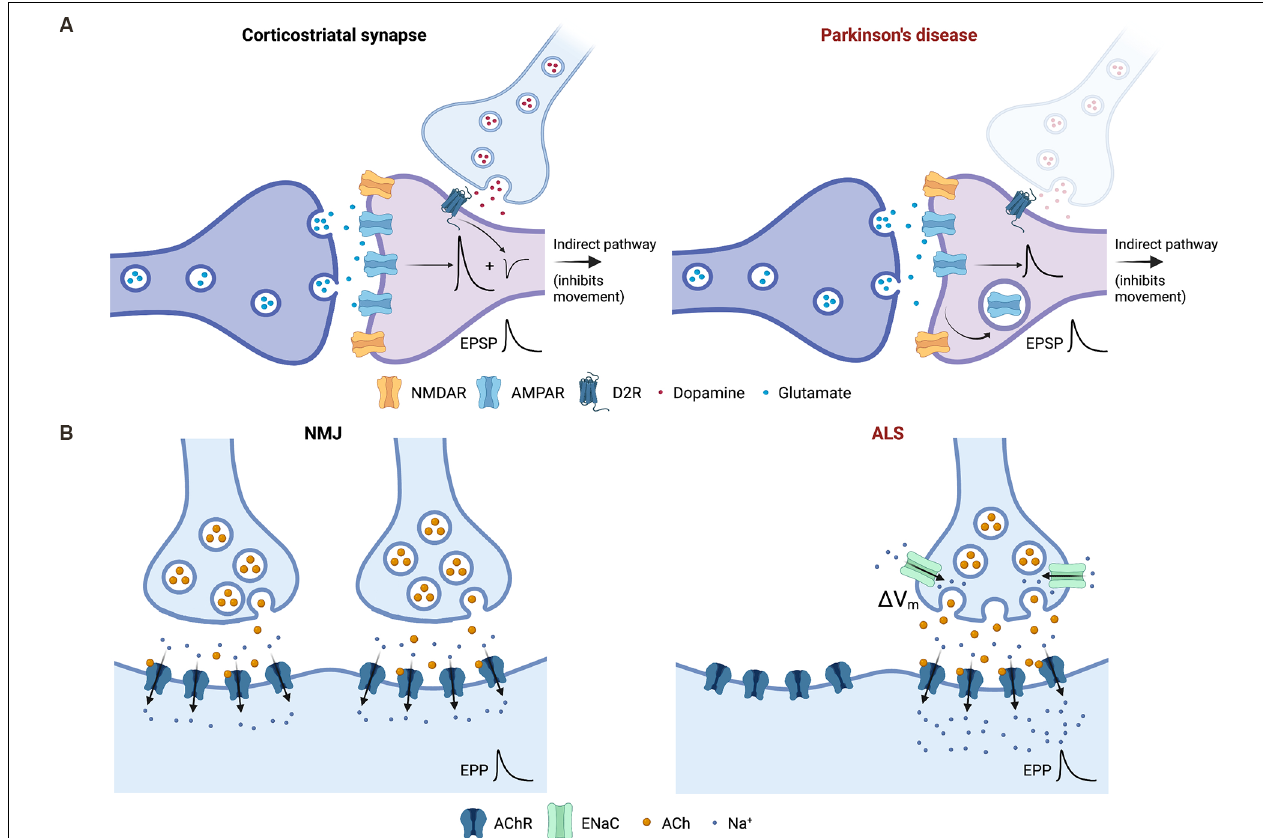
FIGURE 2 | Induction of homeostatic synaptic plasticity (HSP) can support the functioning of neuronal networks and/or populations of synapses in the context of synaptic degeneration. (A) Heterosynaptic and cell non-autonomous induction of HSP supports the function of basal ganglia circuits following degeneration of dopaminergic synapses in Parkinson’s disease (PD). One example of this is shown involving synapses of the indirect pathway, which serves to negatively regulate voluntary movement. In models of PD, the strength of glutamatergic corticostriatal synapses onto medium spiny neurons is scaled down via mechanisms of HSP to compensate for the loss of D2 receptor-dependent inhibition (conceptually represented in the left panel as an inhibitory potential) of the same neuron by the degenerating nigrostriatal dopaminergic projections (right panel). Thus, heterosynaptic induction of HSP ensures that the overall strength of excitatory postsynaptic potentials (EPSPs) measured at the medium spiny neuron soma is preserved. (B) Induction of HSP at the degenerating neuromuscular junction (NMJ) supports motor function and opposes disease progression in amyotrophic lateral sclerosis (ALS) pathogenesis. The left panel shows the NMJ under physiological conditions. The right panel represents early stage ALS, in which innervation of the muscle and motor function is compromised by the loss of motor neuron synapses. This results in the induction of presynaptic HSP in remaining synaptic terminals via the membrane insertion of epithelial sodium channels (ENaC) that constitutively depolarise the presynaptic membrane ( ∆ V m ) and augment neurotransmitter release. This serves to: (1) preserve the strength of degenerating synapses; and/or (2) maintain normal or near-normal levels of postsynaptic depolarisation and end plate potentials (EPP) despite the loss of synaptic terminals, as shown here. Image created with